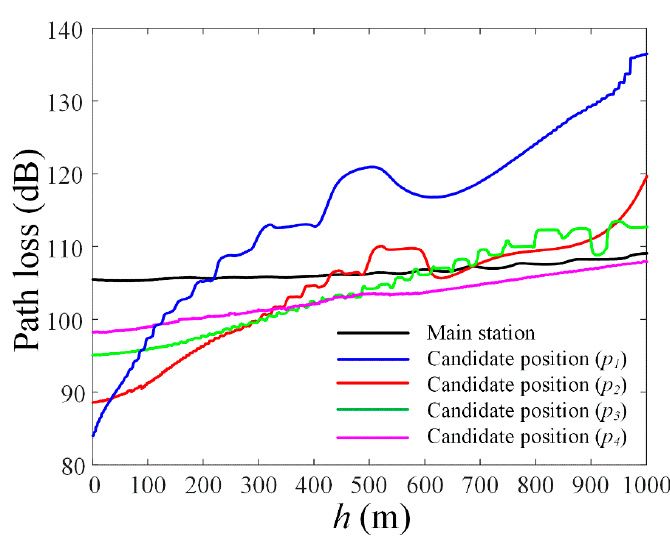
Figure 5. Path loss according to rocket’s altitude.